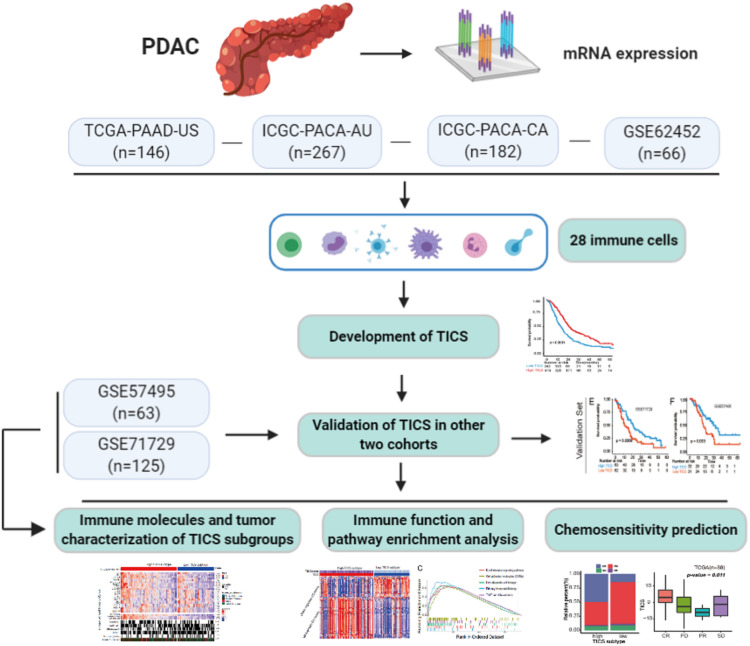
A schematic of the study design and model development. Details of the study design and PDAC patients cohorts classification for model training and validation in regards to the overall survival, immune and tumor characterization, as well as the chemosensitivity prediction.